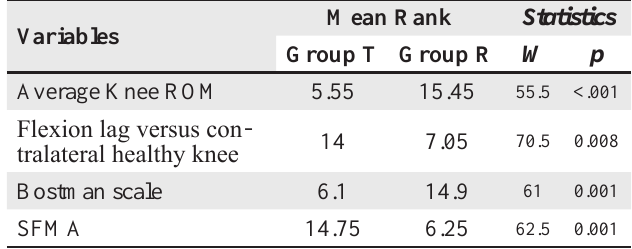
Table 1 : Outcome variables in both groups. Mean Rank Statistics Variables Group T Group R W p Average Knee ROM 5.55 15.45 55.5 <.001 Flexion lag versus con - 14 7.05 70.5 0.008 tralateral healthy knee Bostman scale 6.1 14.9 61 0.001 SFMA 14.75 6.25 62.5